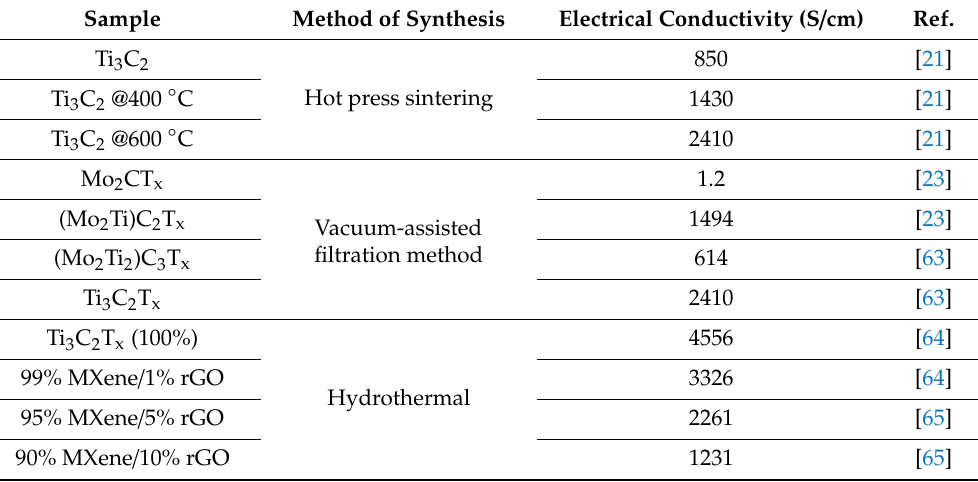
Table 1. Summary of the various MXene nanocomposites with the method of synthesis for electrical